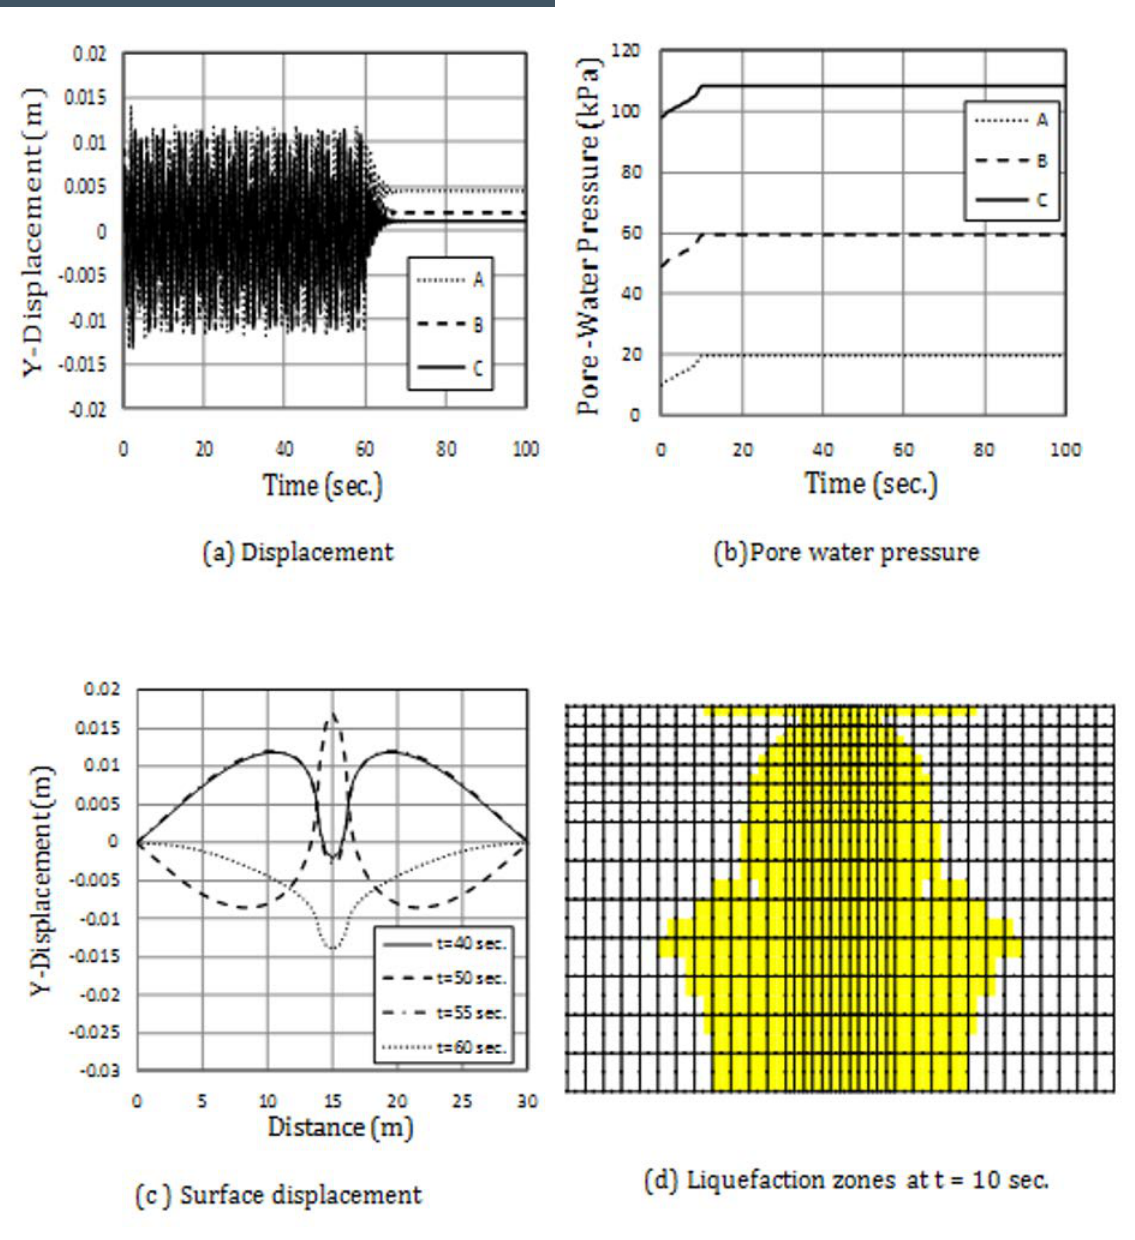
Figure 8. Dynamic response of the foundation to harmonic load, a